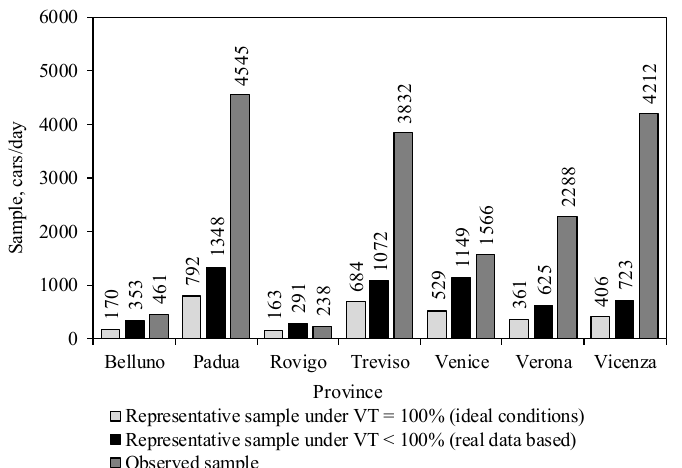
Figure 10. Samples of monitored vehicle numbers under different conditions of activity.